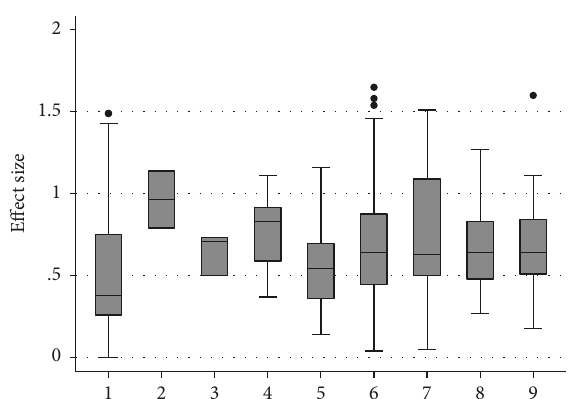
Figure 2: Boxplot reflecting effect size ranges for the sociobe- havioral and cognitive domains. 1 = BAP expression. 2 = other measures of personality and friendships. 3 = social and narrative language. 4 = repetitive, restrictive behaviors, and interests. 5 = general intellectual functioning. 6 = structural language abilities. 7 = social cognition. 8 = executive function. 9 = local visual processing (central